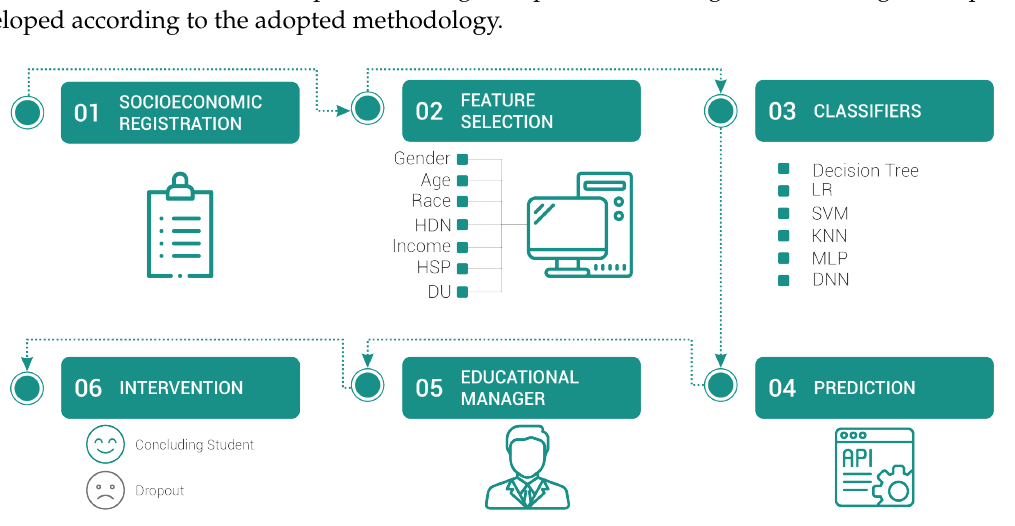
Figure 1. Flowchart of the proposed approach for online detection and classification of possible dropout